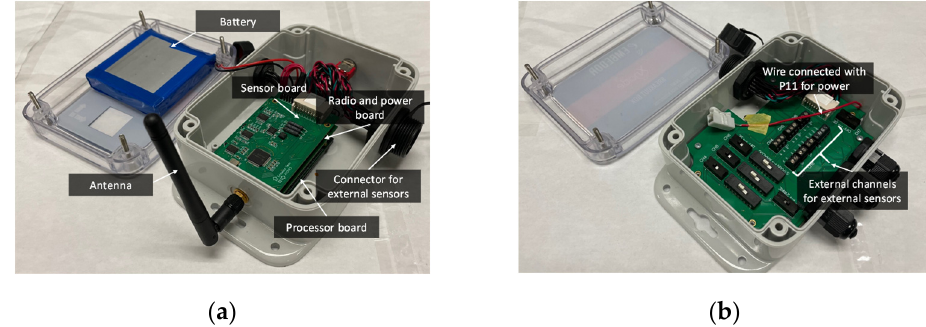
Figure 3. The Xnode wireless smart sensor platform: ( a ) the Xnode sensor node and ( b ) breakout box.